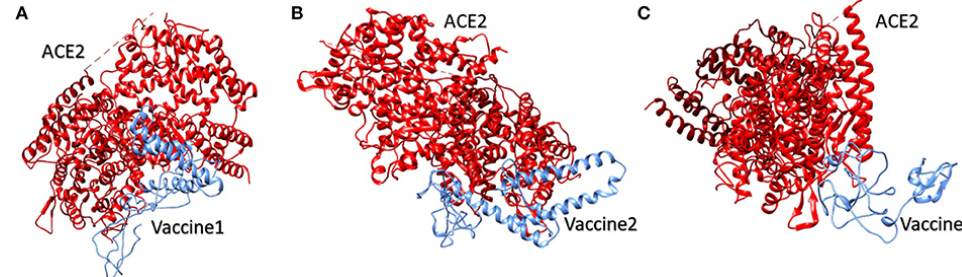
Table 2. Static interaction parameters of ACE-2 with vaccines 1, 2, and 3. Parameter